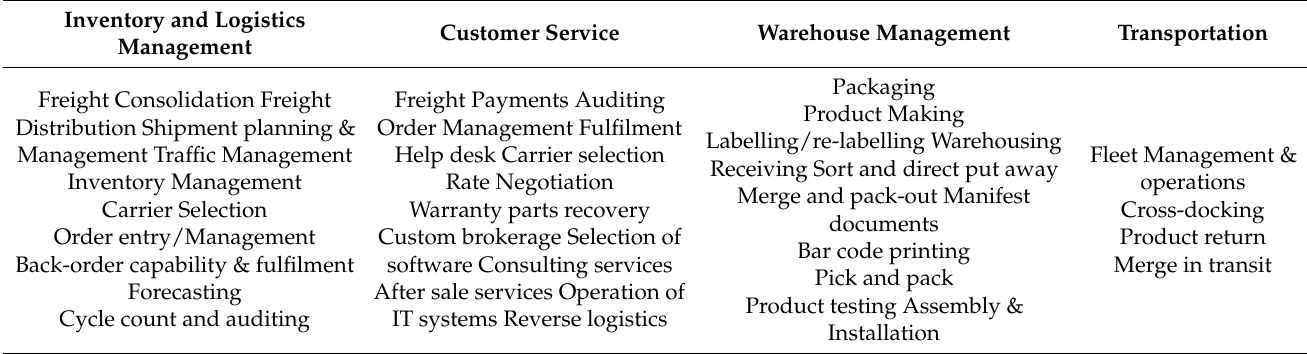
Table 1. VAS in different areas of logistics, adopted from (Herrera and Yang